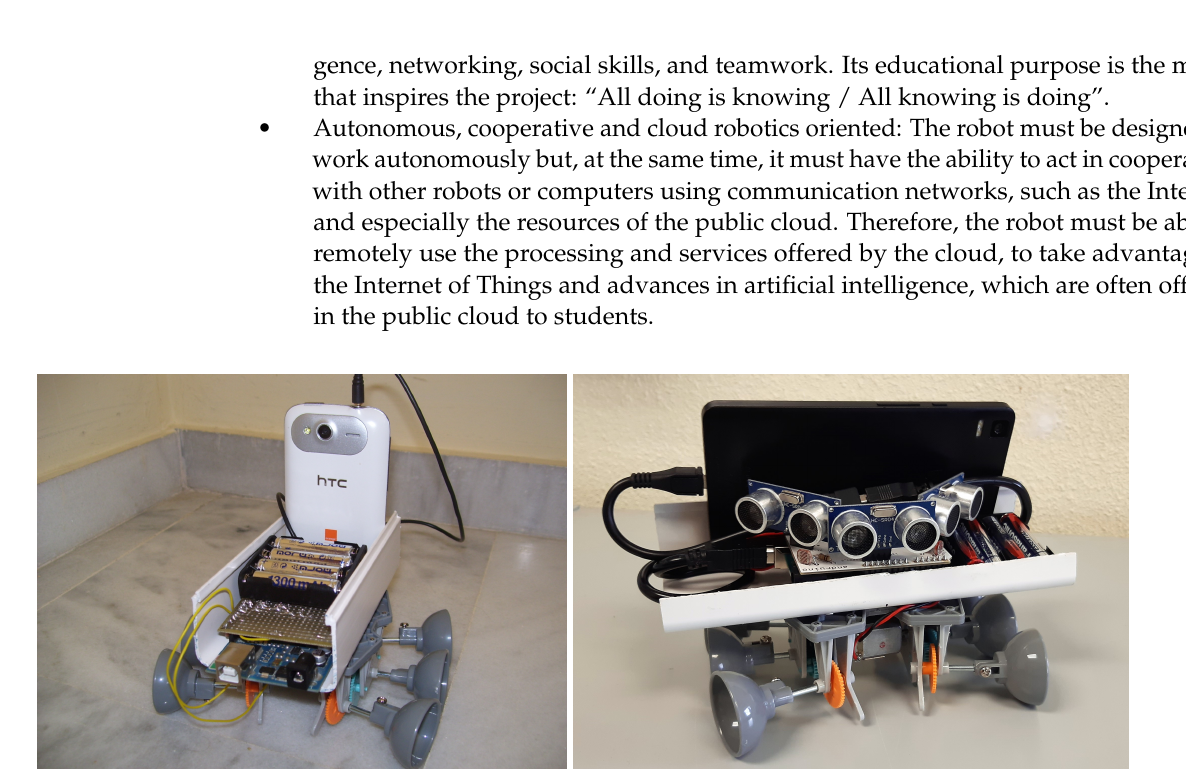
Figure 1. Andruino Robots: Andruino-A1 mobile robot ( left ); New Andruido-R2 mobile robot ( right ).